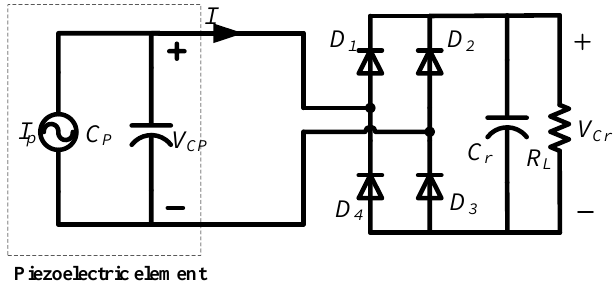
Figure 2. Bridge rectifier interface circuit.